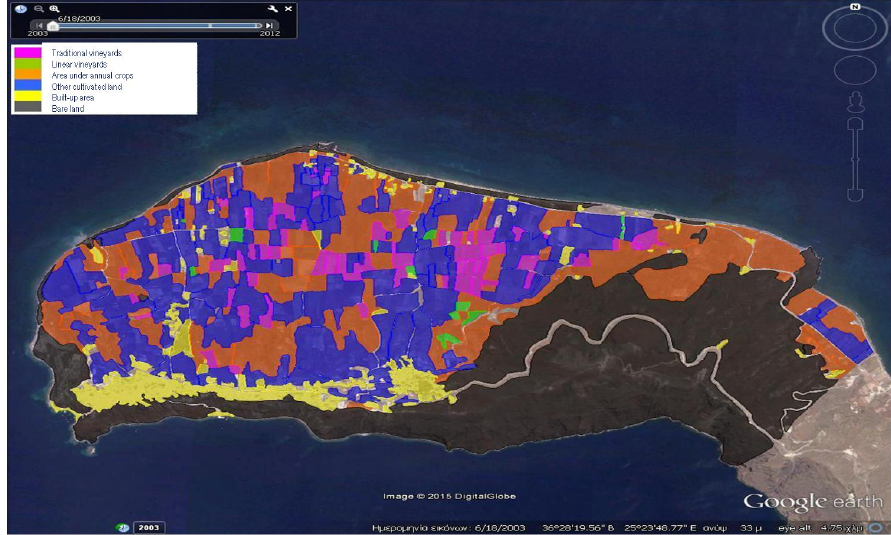
Figure 1. Land cover map of the northern part of Santorini (2003).